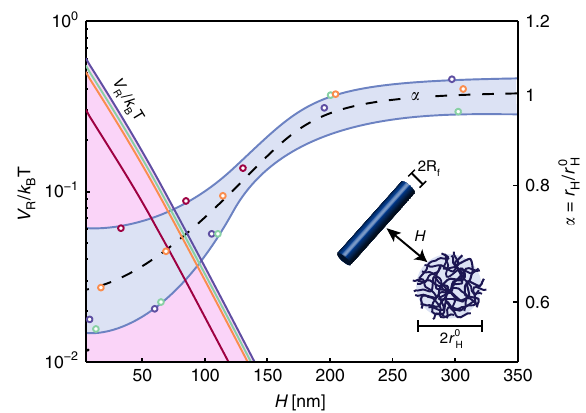
Fig. 4 Electrostatic interactions in the EDL.Theoretical reduced interaction potential, V R /k B T , between a sphere and a fi bre (left axis) and experientally measured NPs shrinking ratio, α , (right axis) as a function of the surface-to- surface distance H . Experimental values for α were collected at different agarose concentrations C ag , which were used to calculate H (see Supplementary Notes 6). The different colors used for the symbols (circles refer to α ) and curves (which refer to V R /k B T ) correspond